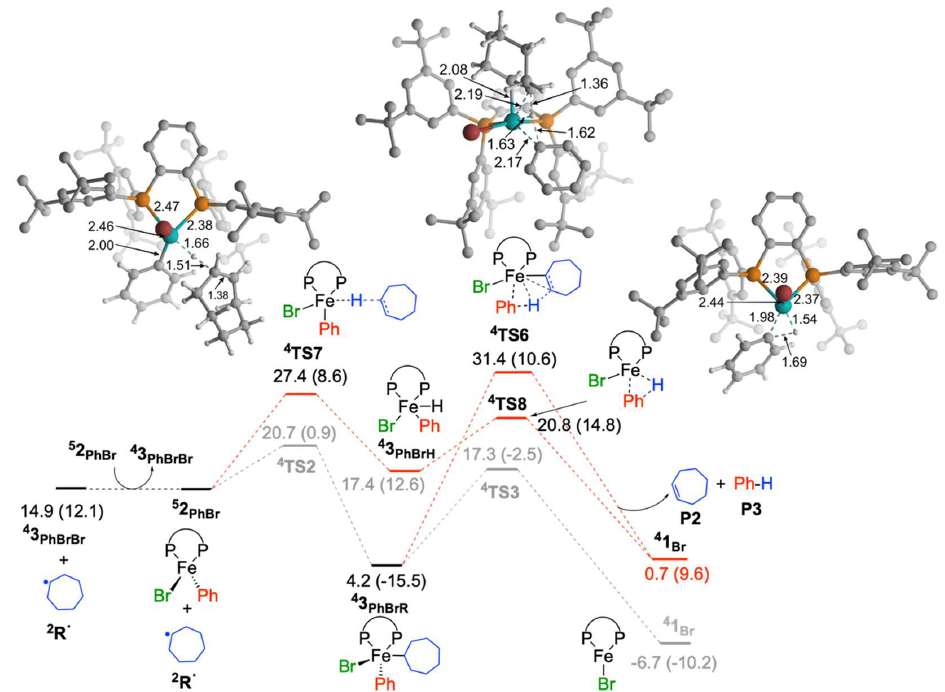
Figure 4. Free energy profile for olefin formation by reaction of Fe II species with cycloheptyl radical, where radical is generated by the reaction of iron(II) species and bromocycloheptane. Free energies with respect to 5 2 PhBr and bromocycloheptane are given in kcal/mol (ΔE ZPE are given in parenthesis).